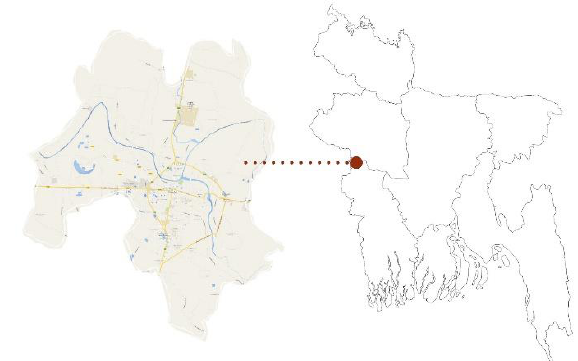
Figure 1: Jhinaidah, on the map of Bangladesh (Google map, 2016) 2. Background of the community-led development project Initially, five low-income communities had